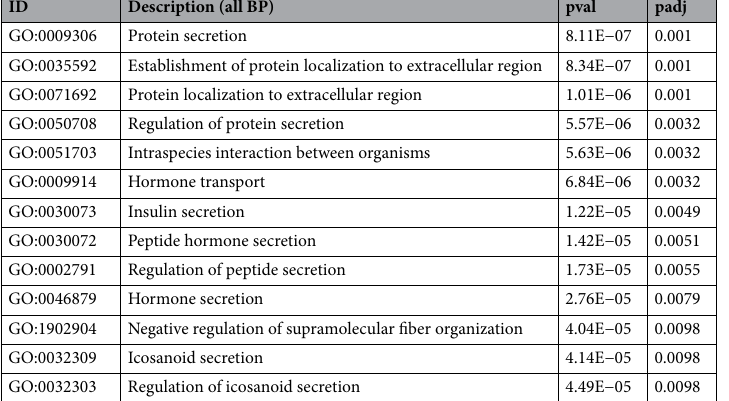
Table 2. GO terms enriched in 182 genes annotated with 443 DMSs. DMS differentially methylated site, BP Biological process, pval enrichment p-value, padj Benjamini–Hochberg-adjusted p-value. The whole output is in ego_10p.csv in Supplementary